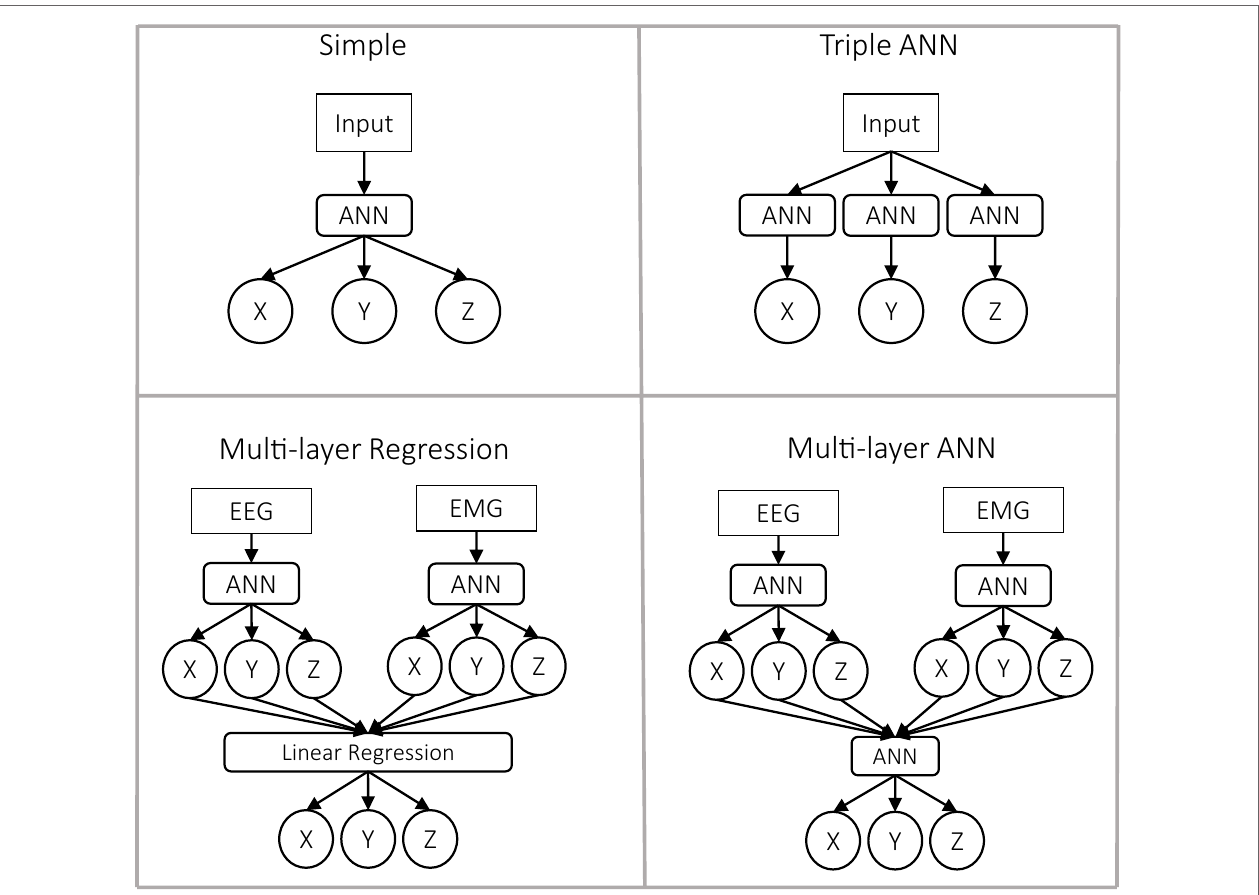
FigUre 3 | representation of the four predictor approaches . In the first row are presented the approaches with a single layer. In those cases, the input can be either only EEG, only EMG, or the concatenation of EEG and EMG as a single vector. In the case of the multilayer approaches, the data are always separated.